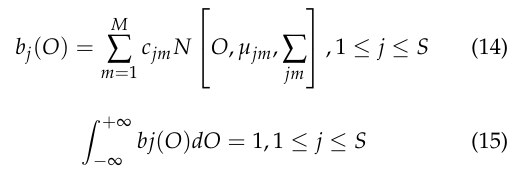
Fig. 2 is a schematic diagram of the Hidden Markov